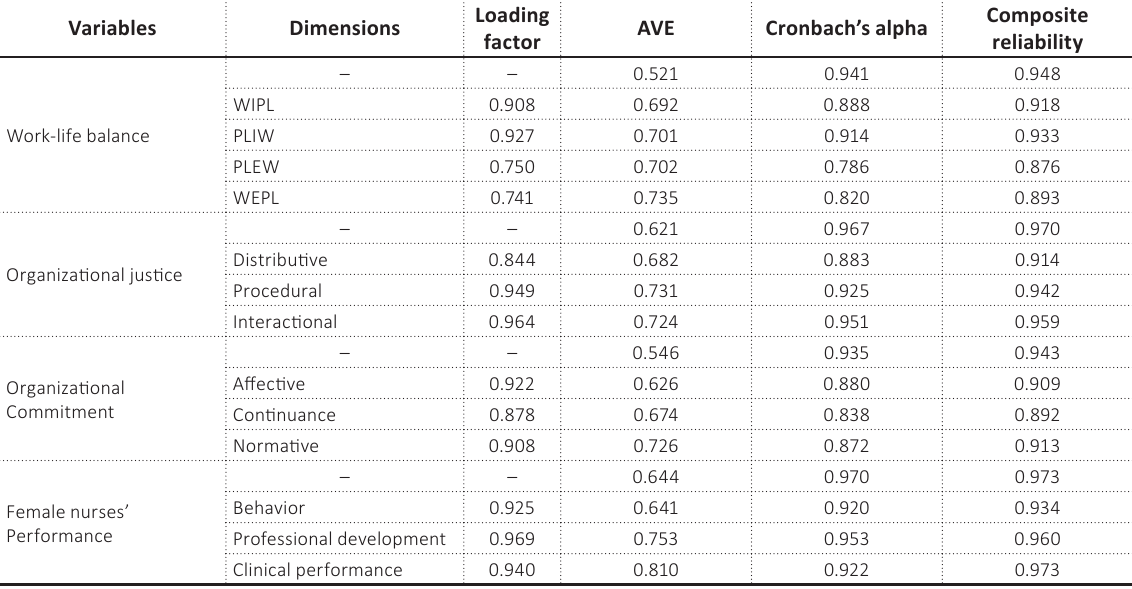
Source: The result of data processing from SmartPLS.